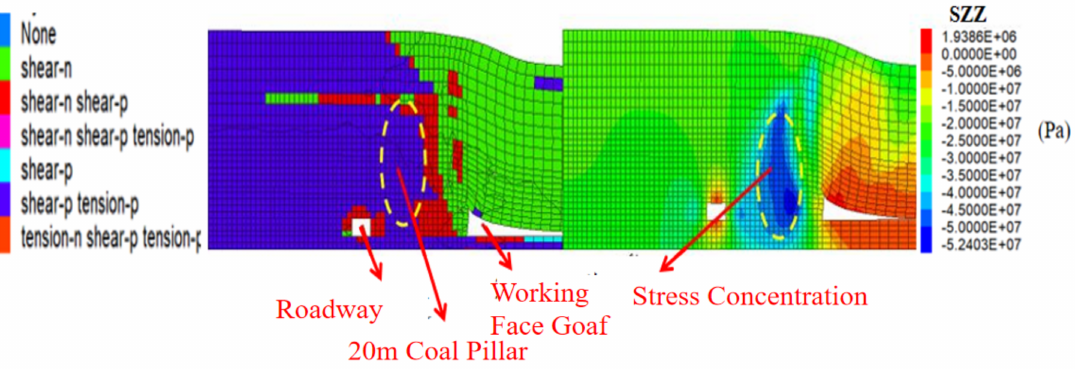
Figure 3. Stress nephogram around the surrounding rock of mining-disturbed roadway. Note: shear- n means shear damage is occurring now; shear-p means shear damage occurred in the past; tension-p means tensile damage occurred in the